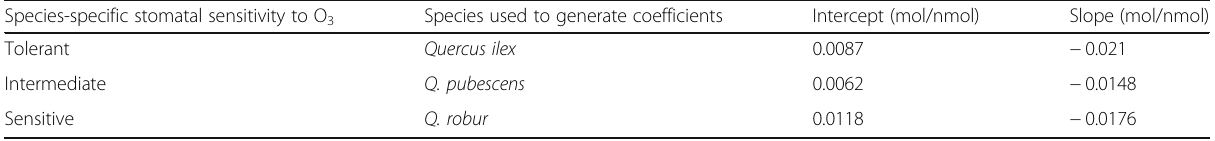
Table 3 Regression coefficients for computing the effects of ozone on stomatal sluggishness (Cimodifier) based on data from Hoshika et al. (2018a, b) Species-specific stomatal sensitivity to O 3